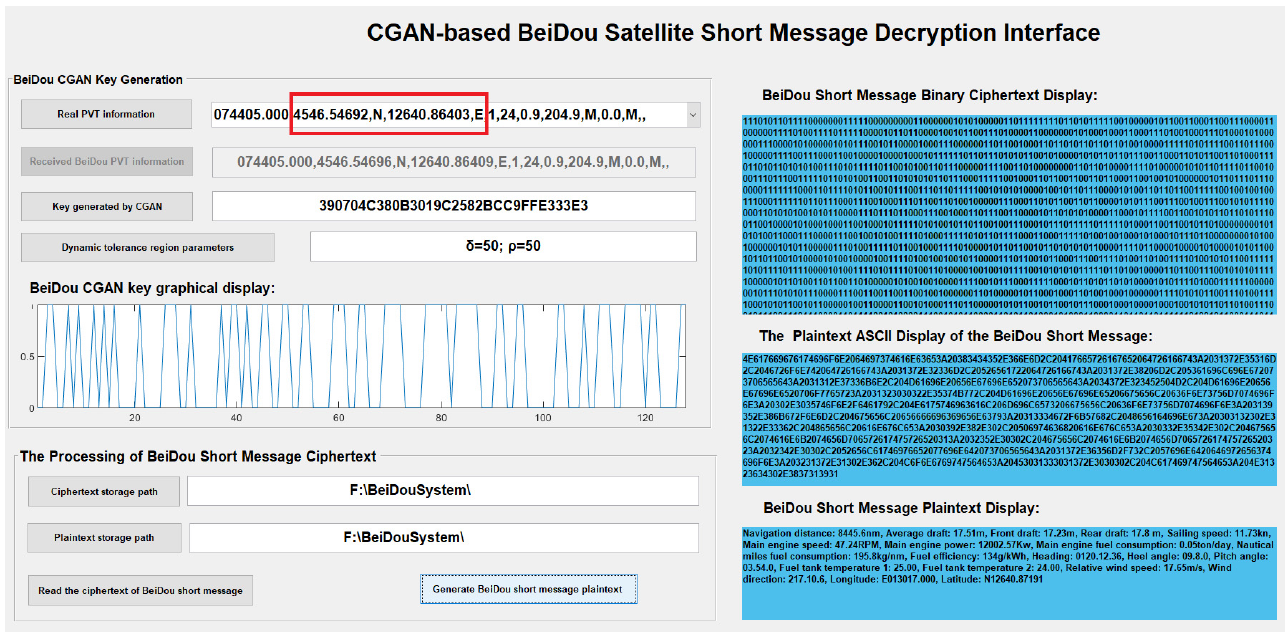
Figure 15. CGAN-based BeiDou satellite short message decryption interface.